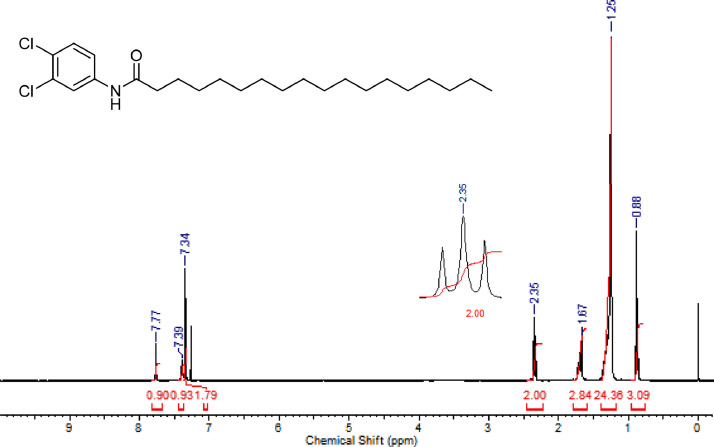
1H NMR (CDCl3, 400 MHz) spectrum of compound 11b.